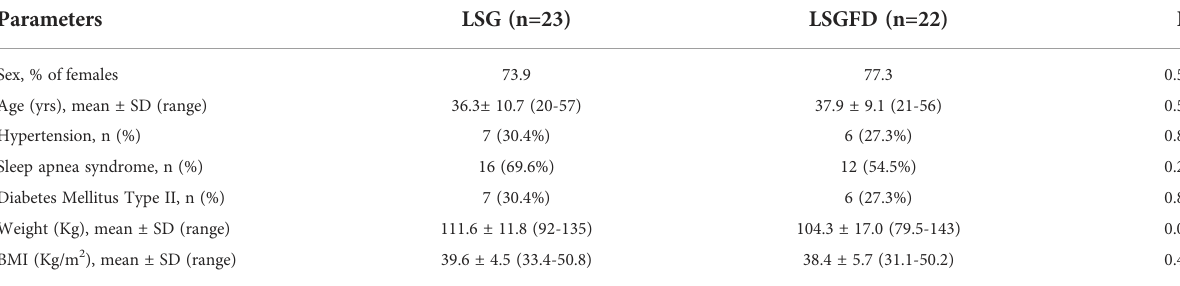
TABLE 1 Patient ’ s demographics and preoperative evaluations.